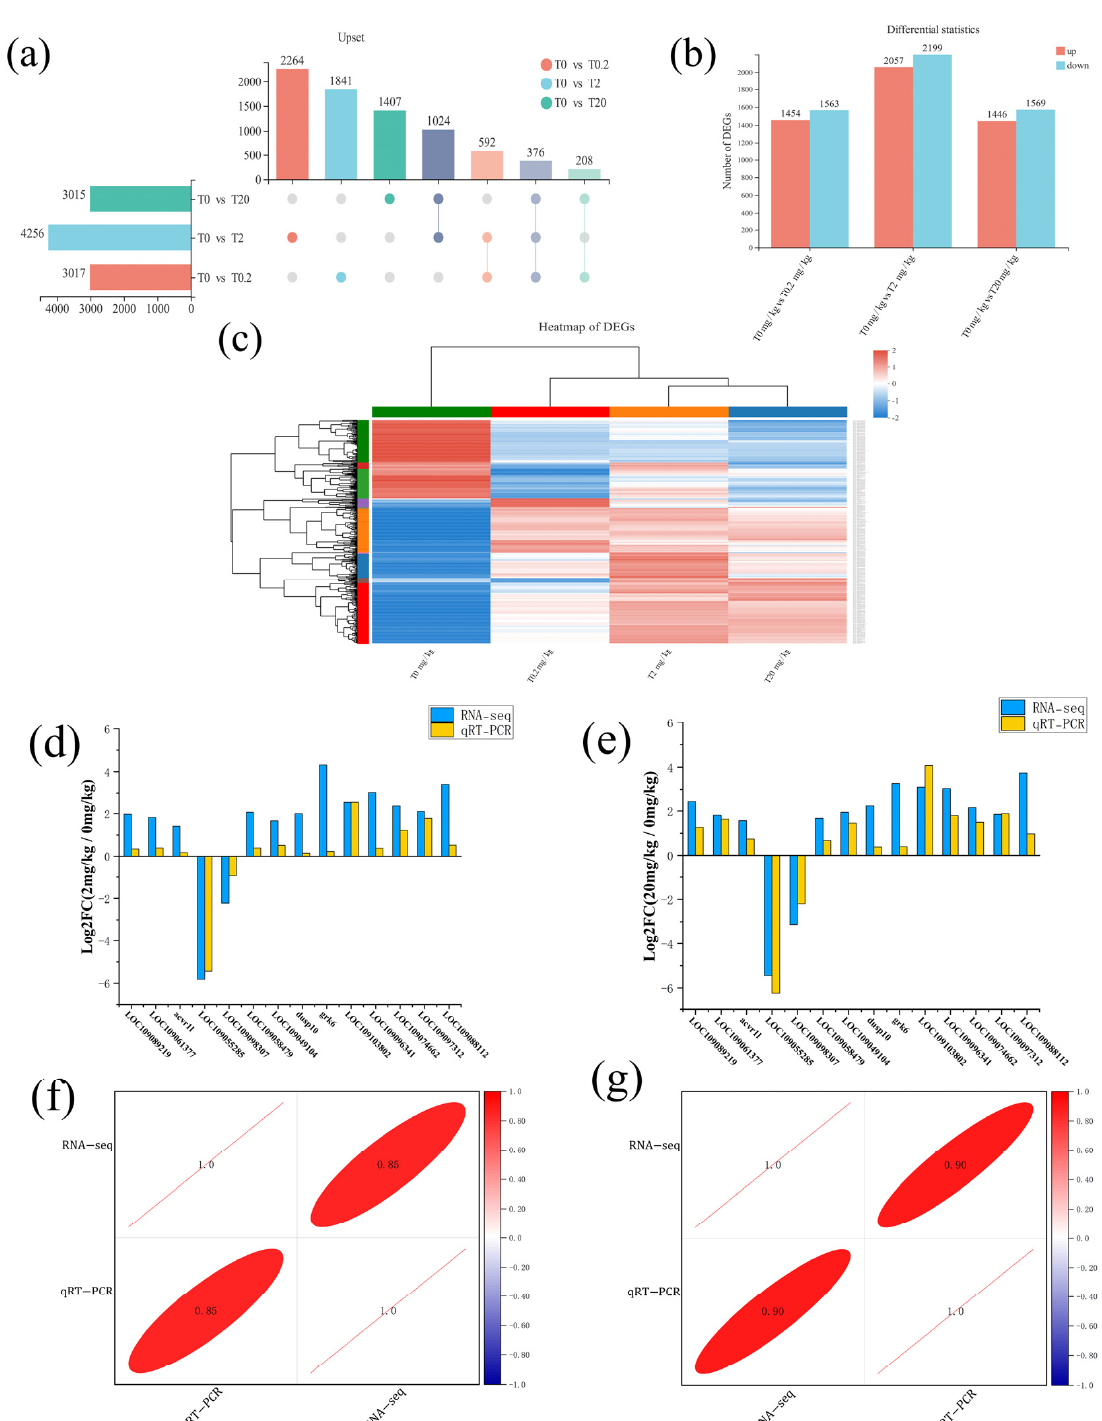
Figure 4. DEG Cluster profiling and validation of DEG data by qRT-PCR: ( a ) comparative results of transcripts between different groups: ( b ) DEG histogram after 71 days of feeding at the indicated concentrations of KM; ( c ) DEG clustering; ( d ) comparison of relative Log 2(fold change) between RNA-seq and quantitative (q) RT-PCR; 2 mg/kg group; ( e ) comparison of relative Log 2(fold change) between RNA-seq and qRT-PCR; 20 mg/kg group; ( f ) correlation analysis diagram of gene expression; 2 mg/kg group; ( g ) correlation analysis diagram of gene expression; 20 mg/kg group.